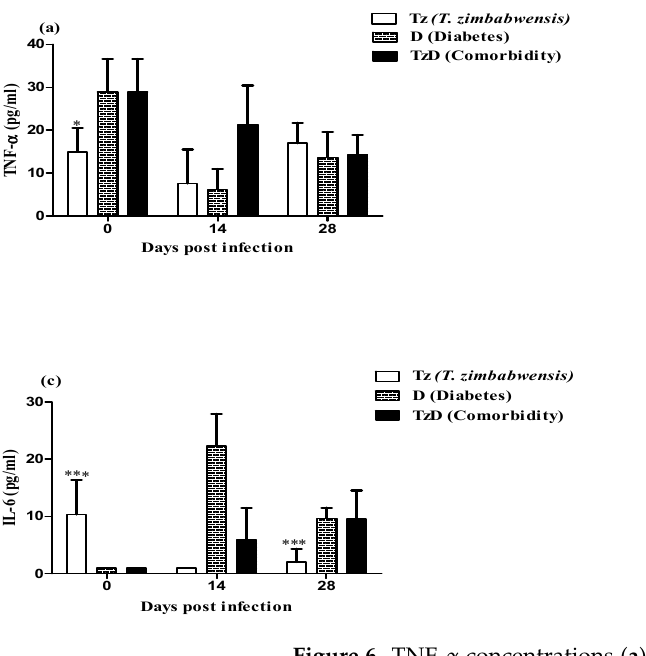
Figure 6. TNF- α concentrations ( a ) IFN- γ concentrations ( b ) and IL-6 concentrations significance asterisk in the Tz is compared to D and TzD ( c ) in male Sprague Dawley rats that were comorbid with type 2 diabetes mellitus (TzD), diabetic (D) and infected with Trichinella zimbabwensis (Tz). Values are presented as mean ± SEM ( n = 6 in each group) and asterisks represent significant differences between the groups (* p < 0.05, *** p < 0.001).